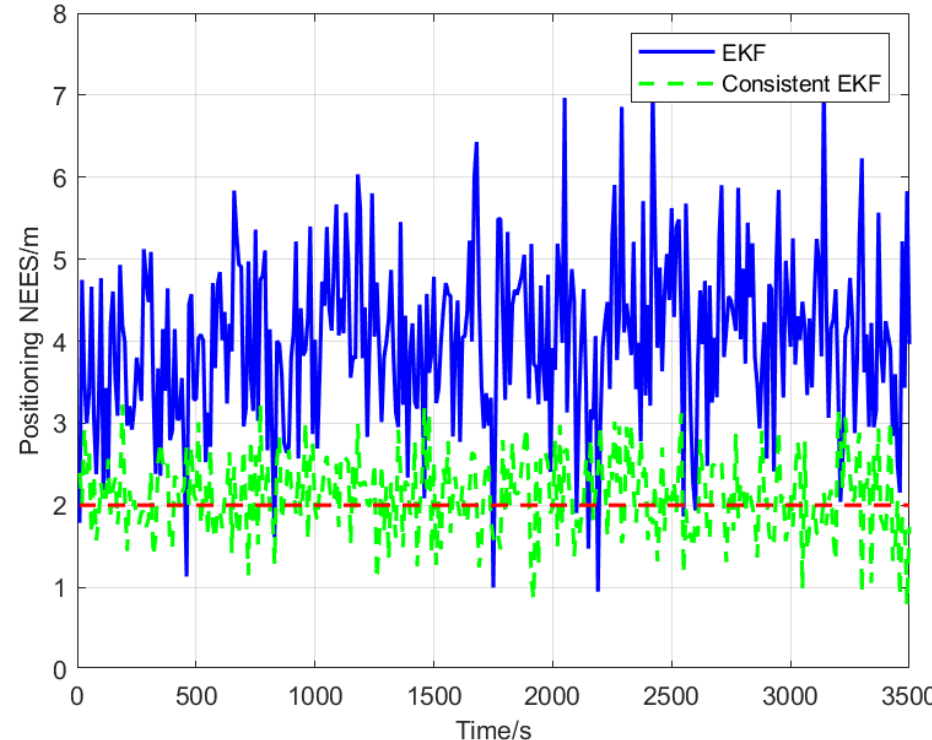
Figure 6. Normalized estimation error squared of position.